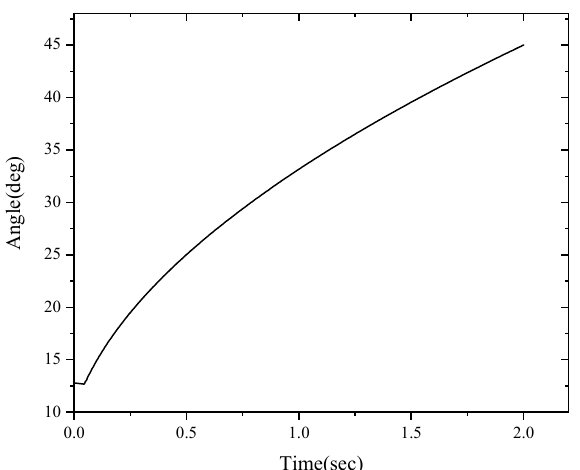
Figure 3. Variation curve of scale blade angle with time.